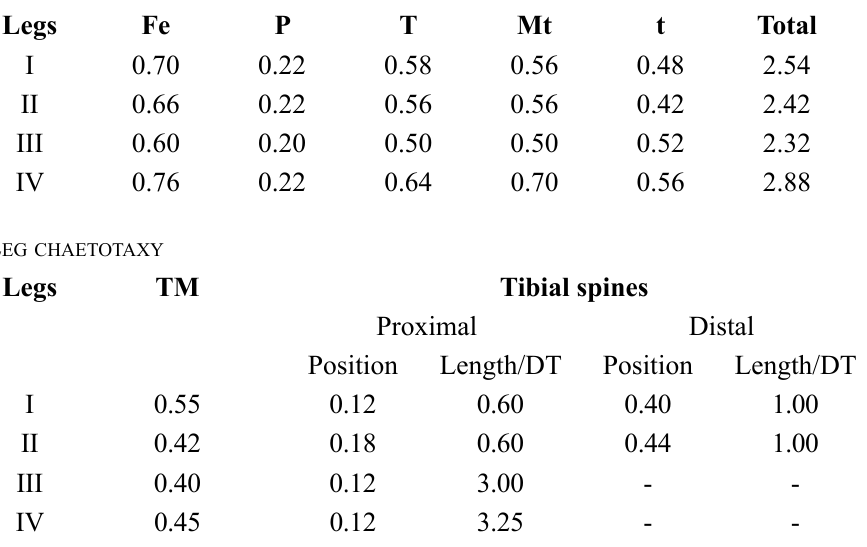
a bdoMen . Oval, greyish black, with faint central dark brown band and small pale points, with six transverse pale chevrons in posterior half. Spinnerets yellowish grey, conical. p alp (Figs 7, 10, 35-38). Dorsal tibial apophysis triangular, with two teeth near tip; retrolateral tibial apophysis almost as long as dorsal one, ending in sharp, slightly curved tip. Paracymbium with proximal arm without hairs; distal arm ending in well delimited, rounded knob. Subtegulum with transverse ventral grooves. Embolic division with short, curved embolus, posterior appendage very short and smoothly rounded; dorsal appendage triangular; frontal appendage short, club-shaped, with frontal margin with many small teeth.